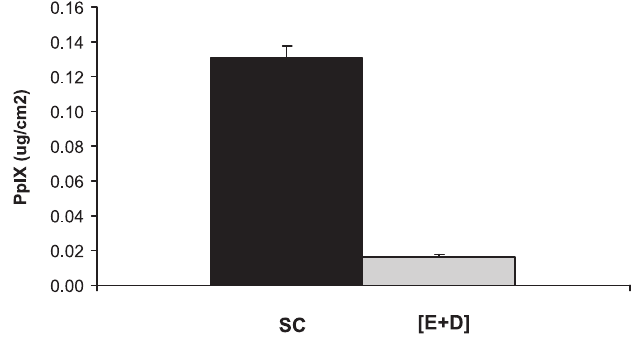
FIGURE 4 - PpIX in vitro penetration in the SC and [E+D] at 12 hours post-application of a photosensitizer solution in polyethylene glycol (80 μg/mL). Results presented are expressed as averages ± SEM of five